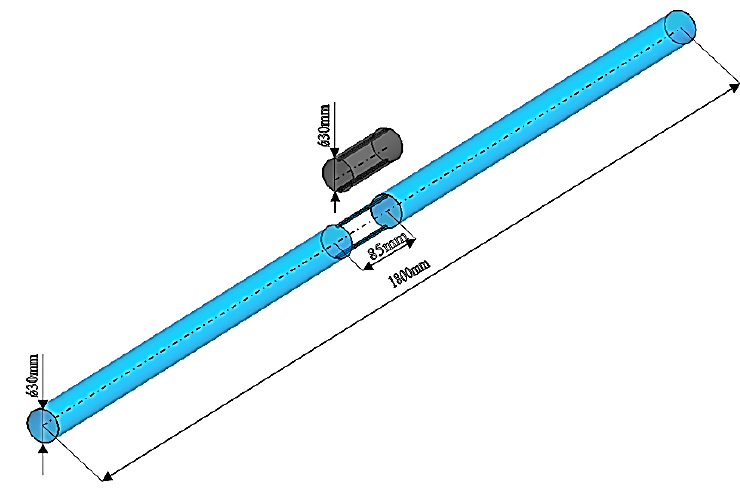
Figure 18. Main dimensions of the 3D model of the reactor.